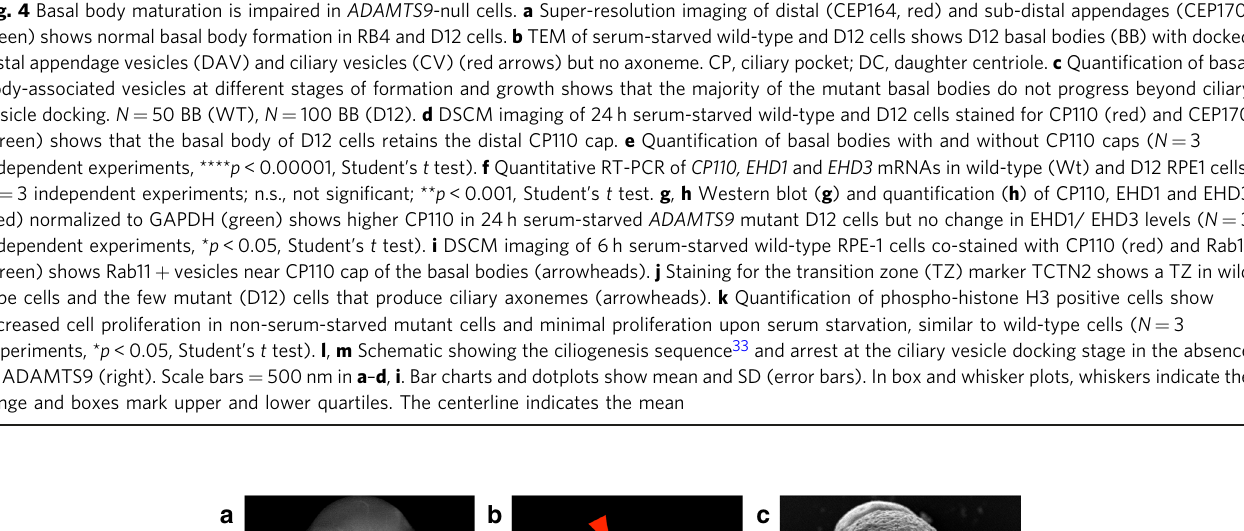
(Fig. 10a). ADAMTS9, having undergone obligate, regulatory glycosylation in the secretory pathway 56,58 , binds to the cell surface, which may be via HSPG, LRP1/2 and furin interac- tion 12,20 and is activated by furin 20 . It is then recycled to the